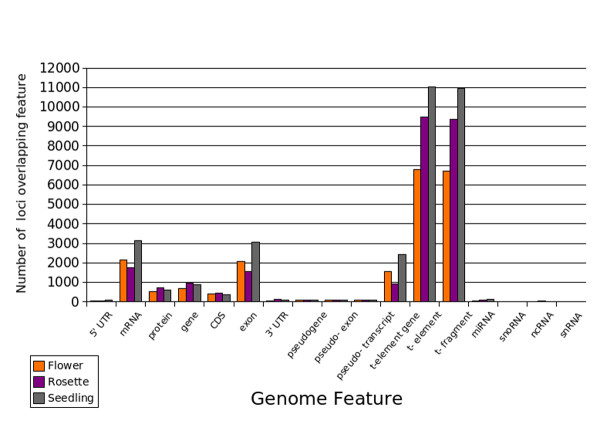
Arabidopsis genomic features overlapped by locales generated with parameter values M = 5 and C = 0.25. TAIR 8 genome annotations were used as reference features and the number of locales overlapping each genomic feature was calculated. All nested features e.g genes within transposable elements were marked with overlaps equally as appropriate.